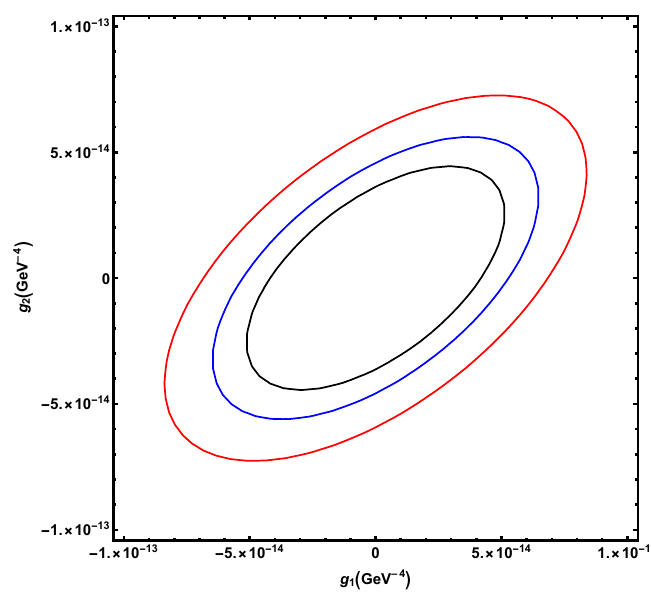
Figure 6 . The 95% C.L. exclusion regions for the couplings g 1 , g 2 in the unpolarized reaction γγ → γZ at the CLIC with the systematic errors δ = 0% (black ellipse), δ = 5% (blue ellipse), and δ = 10% (red ellipse). The inner regions of the ellipses are inaccessible. The collision energy √ is s = 1500 GeV, the integrated luminosity is L = 2500 fb − 1 . The cut on the outgoing photon invariant mass m γγ > 1000 GeV was imposed.